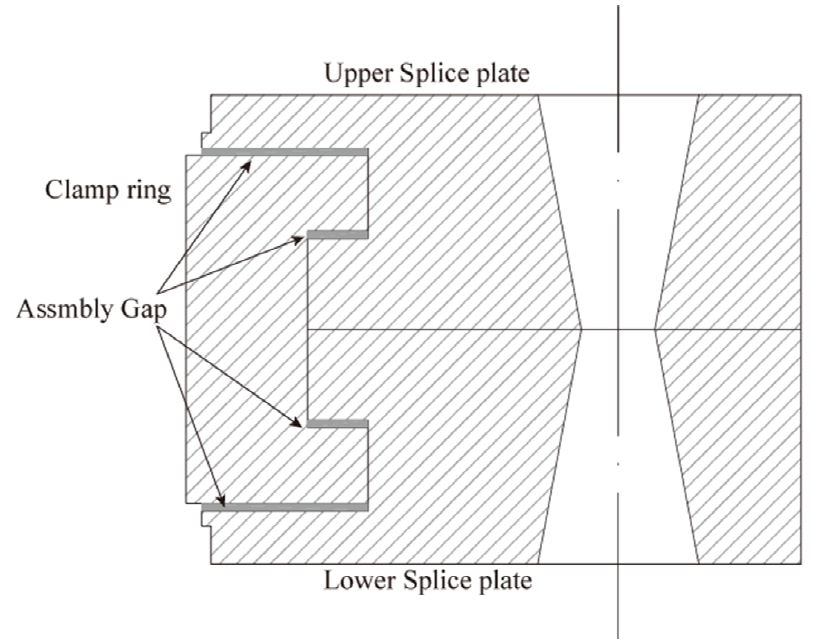
Figure 16. Assembly gap of Combination Splice.